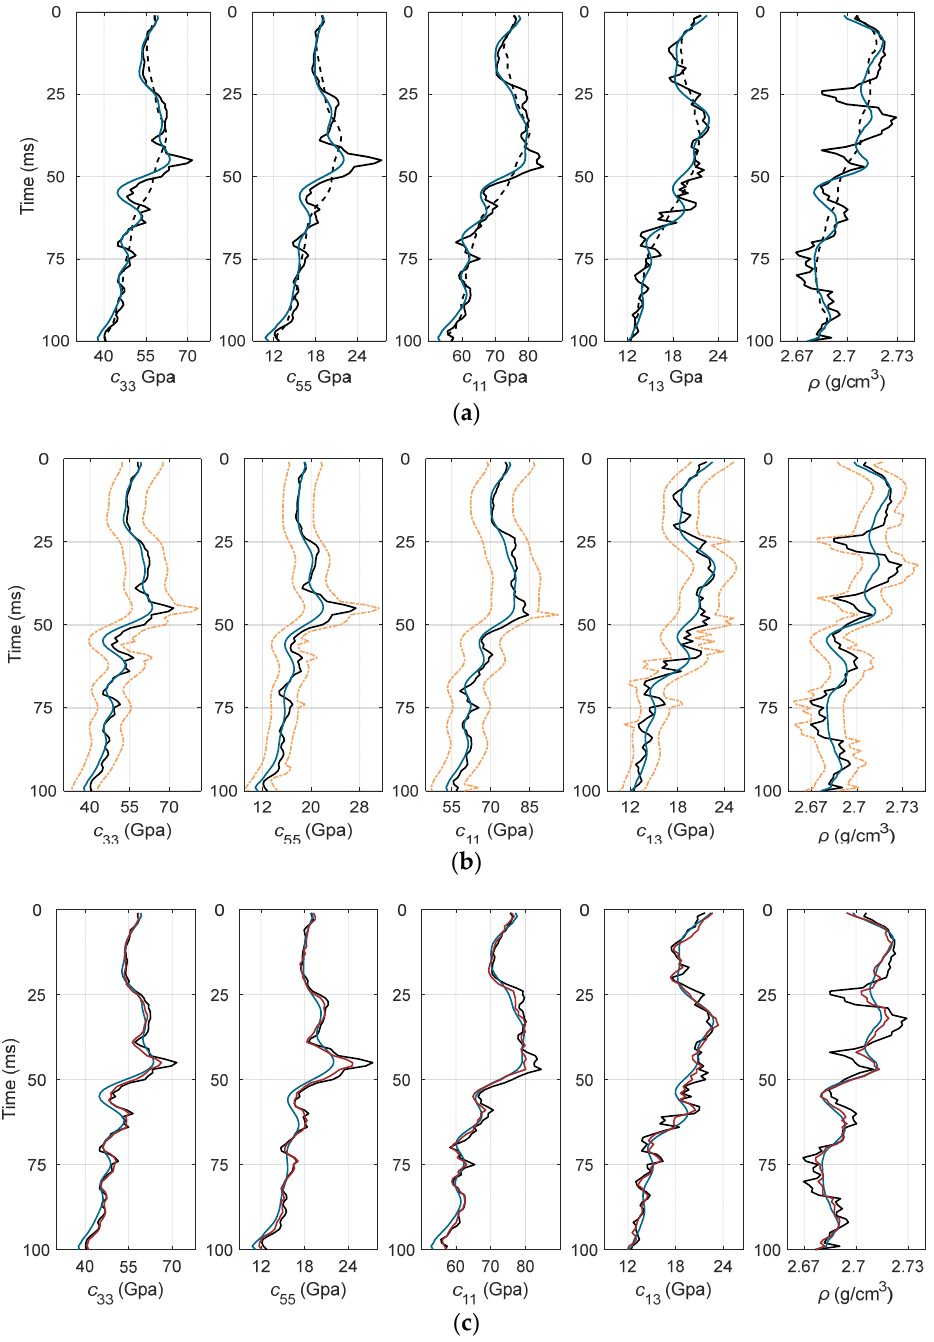
Figure 10. Inversion results with the well model by the proposed method. ( a ) The preliminary result using Rüger approximation based linear optimization (the linear step of the proposed scheme), ( b ) the search limit generated based on ( a ), and ( c ) the final result by the FSA with the adaptive settings of optimization parameters (the nonlinear step of the proposed scheme). The black solid, black dash, and orange dash curves are the true logs, the initial model, and the search limit, respectively. The preliminary and fi nal inversion results are indicated by blue and red curves.